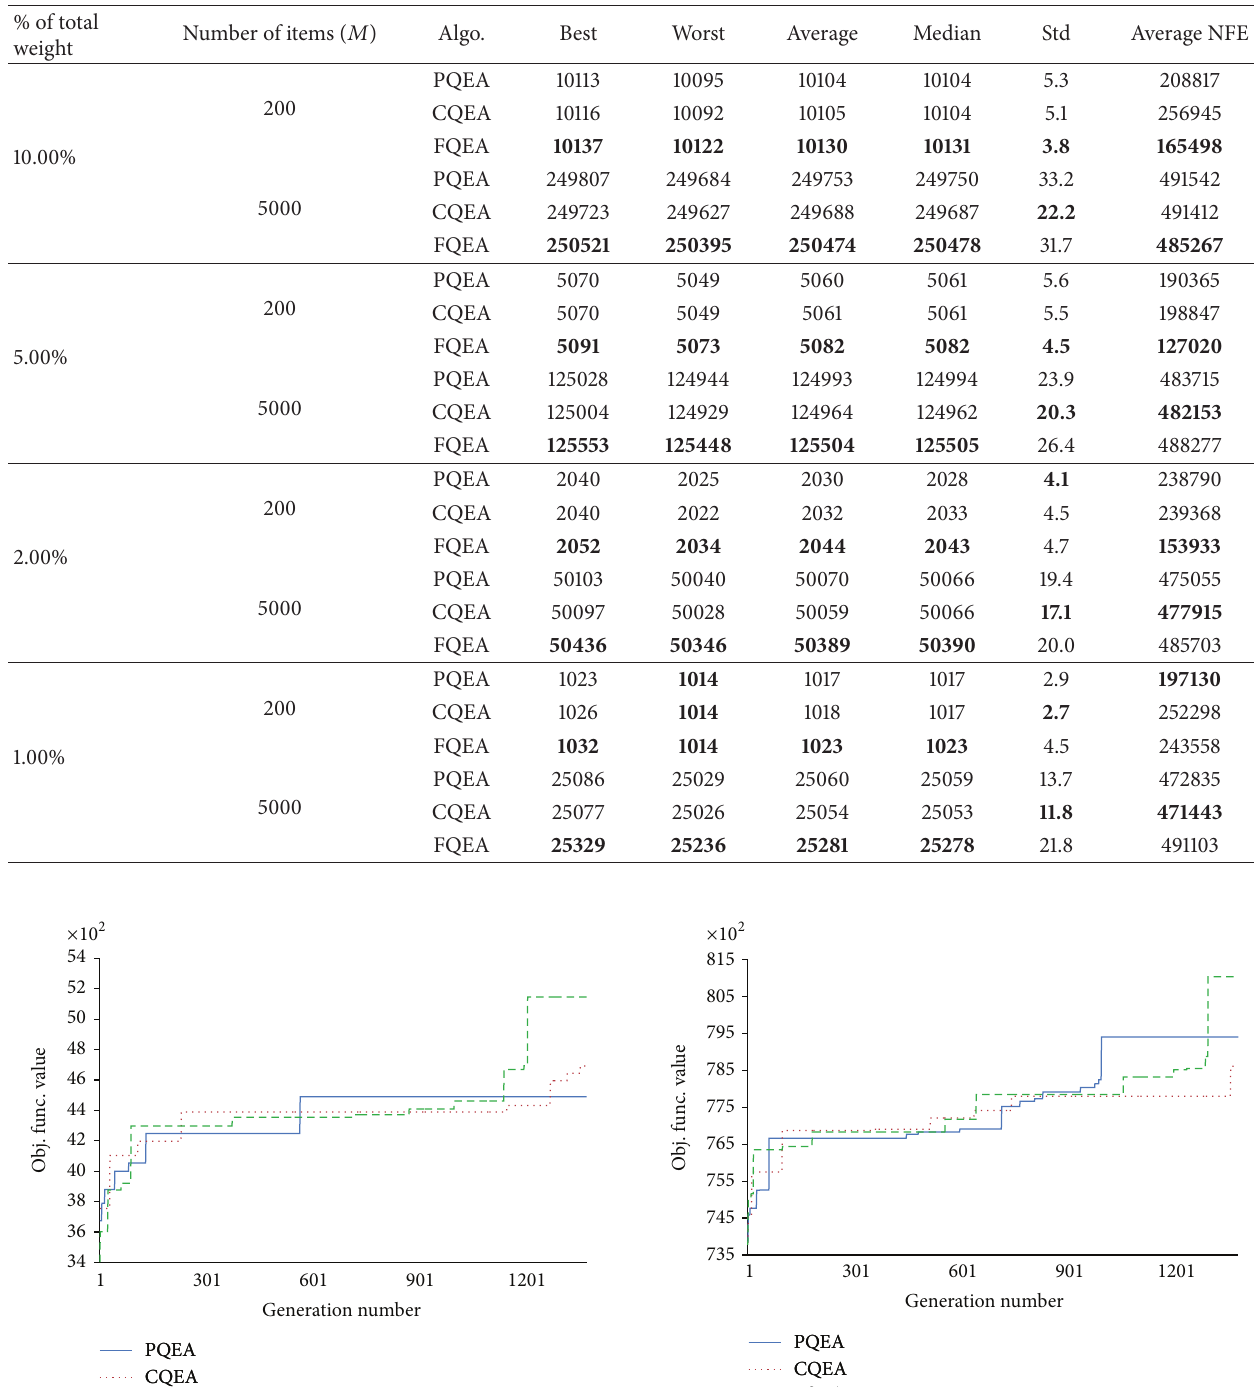
Table 5: Comparative study between PQEA, CQEA, and FQEA using statistical results on 0-1 knapsack problem with profit ceiling data instances.